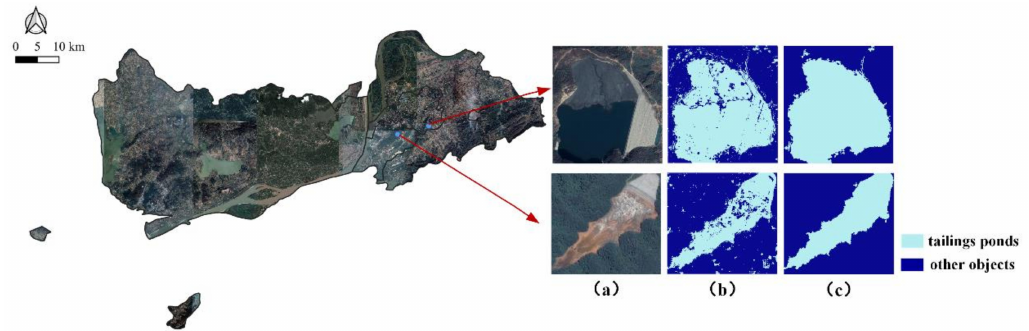
Figure 8. Examples of tailings pond extraction results based on the proposed method. ( a ) are the target areas of the tailings ponds identified by YOLOv4, ( b ) are the extraction results by random forest model and ( c ) are the results of b after morphological processing.